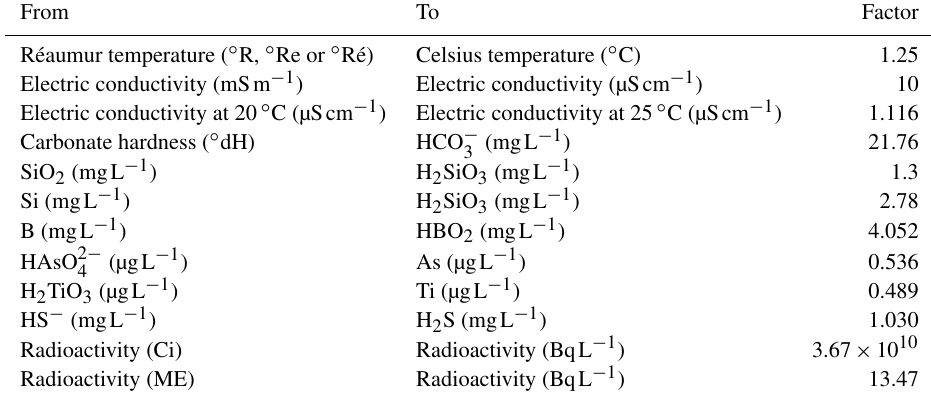
Table 1. Conversion of obsolete units into contemporary units or species preferentially used today in water analysis (cf. Käß and Käß, 2008).